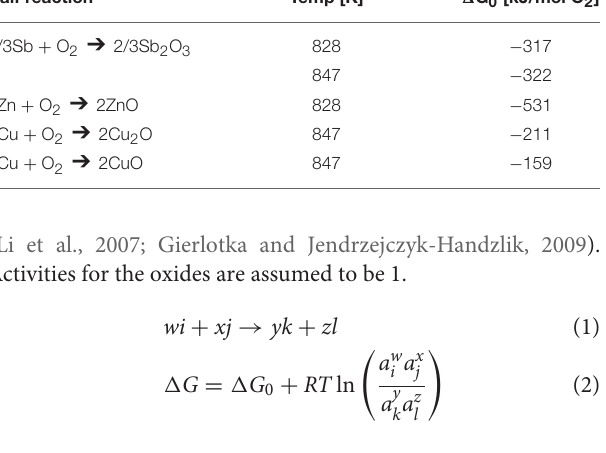
TABLE 2 | Thermodynamic half-reactions of Sb, Zn, and Cu at relevant heat treatment temperatures. Half reaction Temp [K]